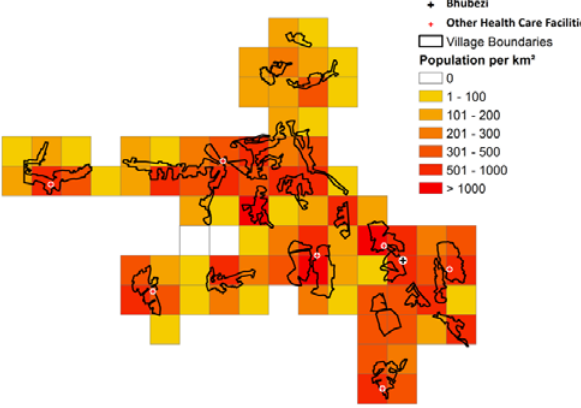
Figure 2. Mean population densities within the study site,